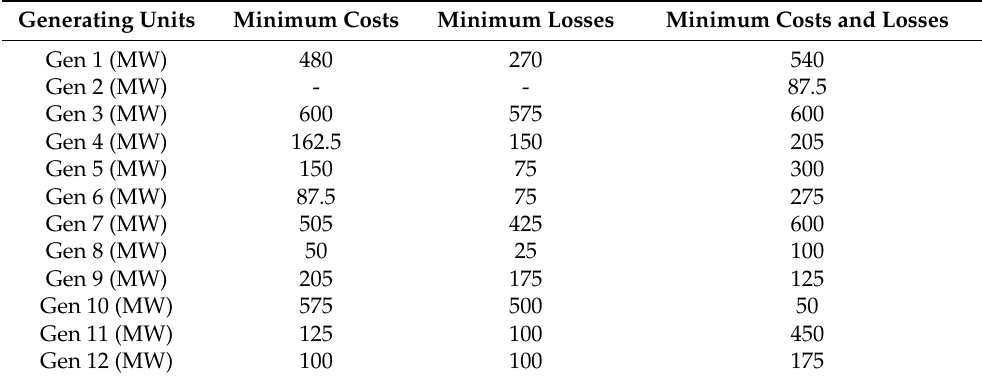
Table 7. Optimal wind power considering different objective functions for Nigeria system.